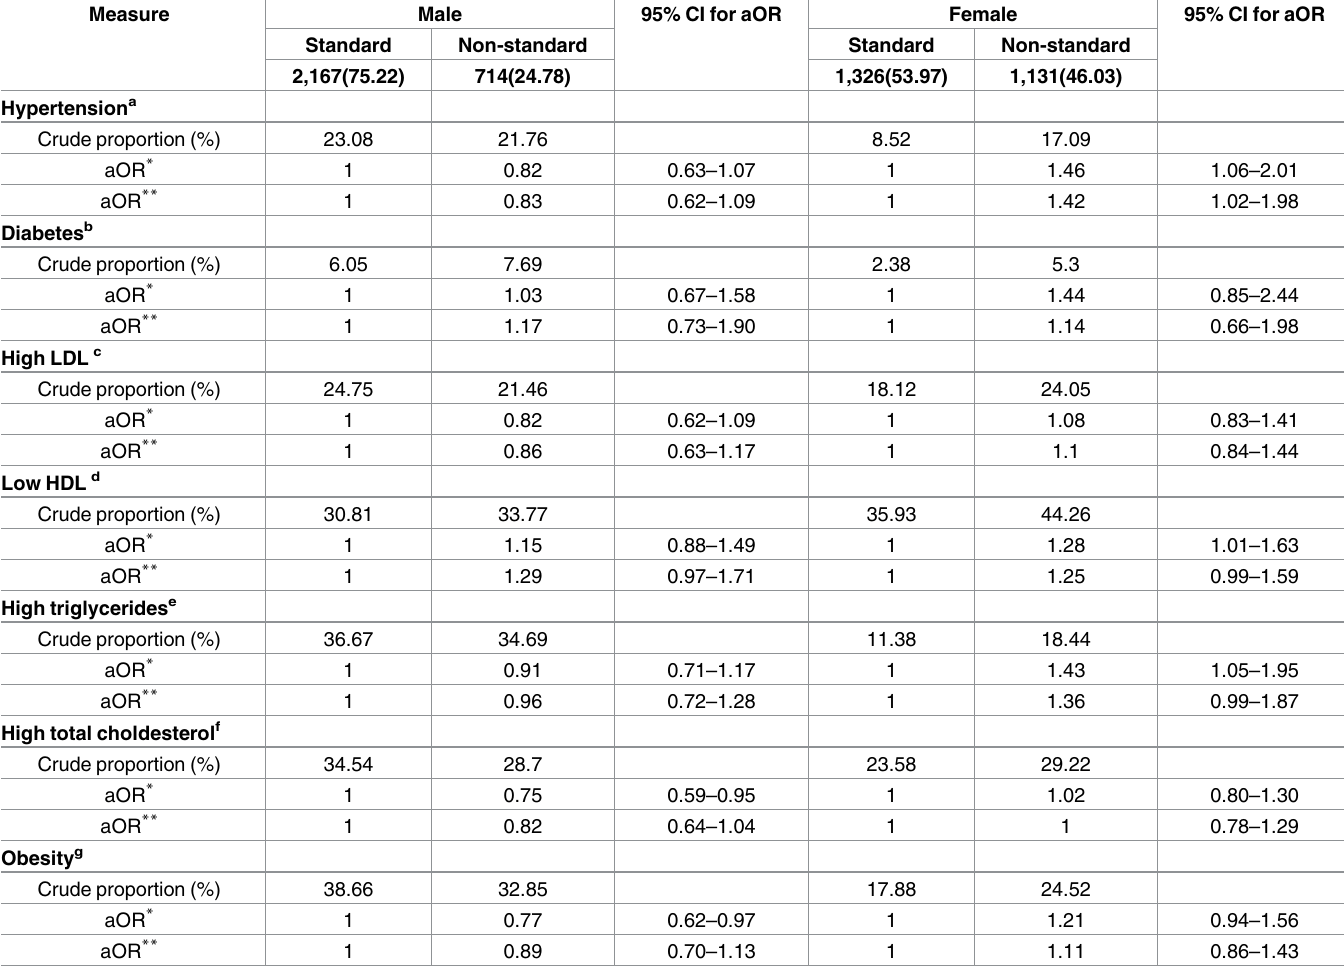
Table 3. Differencesin the measuredcardiovascular morbidities between the standard and non-standard employees.